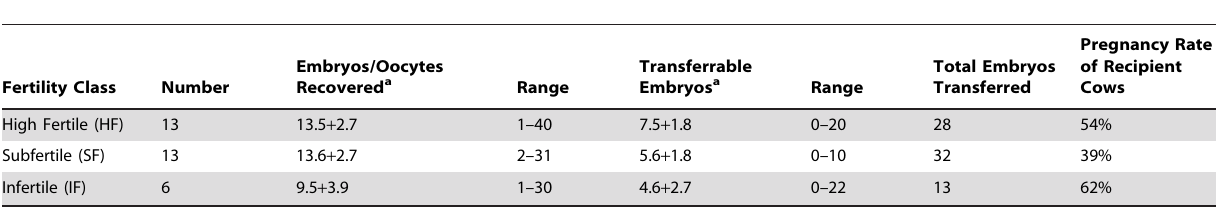
Table 1. Summary of an embryo transfer experiment using fertility classified heifers as embryo donors.